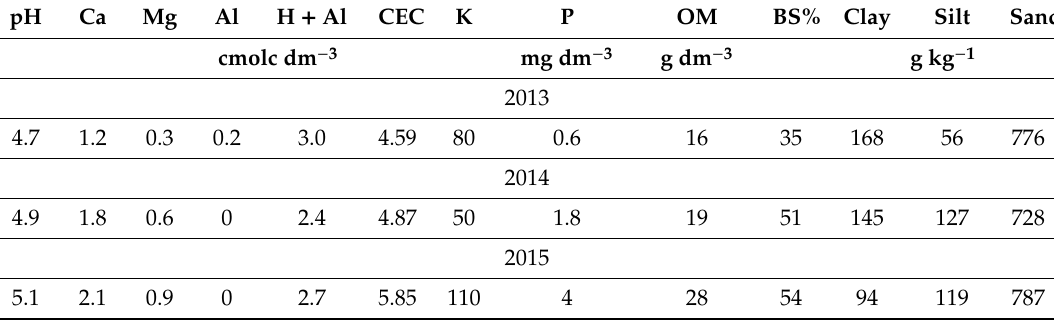
Table 1. Analytical results of soil analyses performed at the experimental